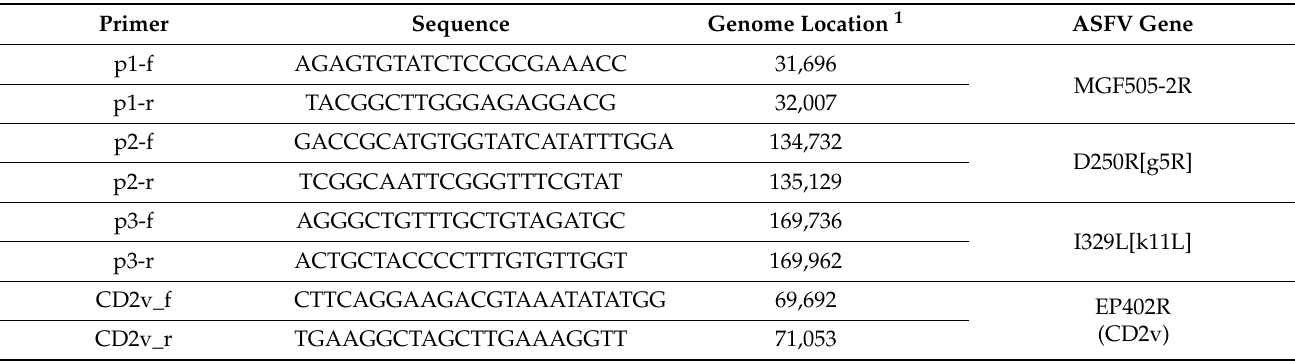
Table A1. Primers used for PCR amplification for the generation of products for Sanger